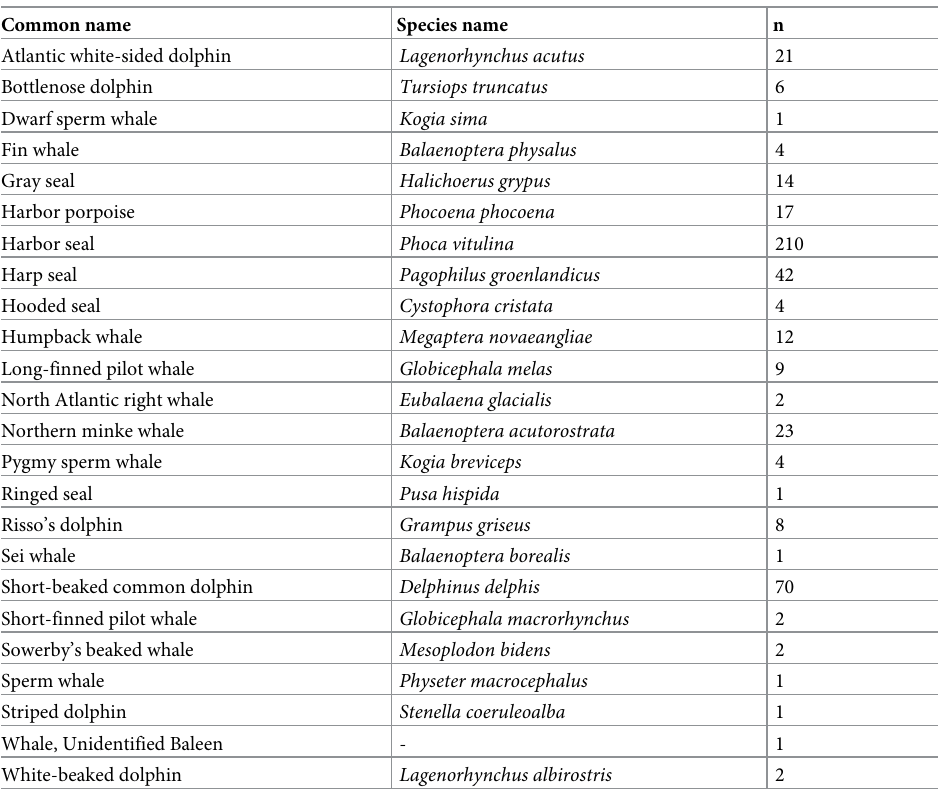
Table 1. Number of sampled animals by common name and species.